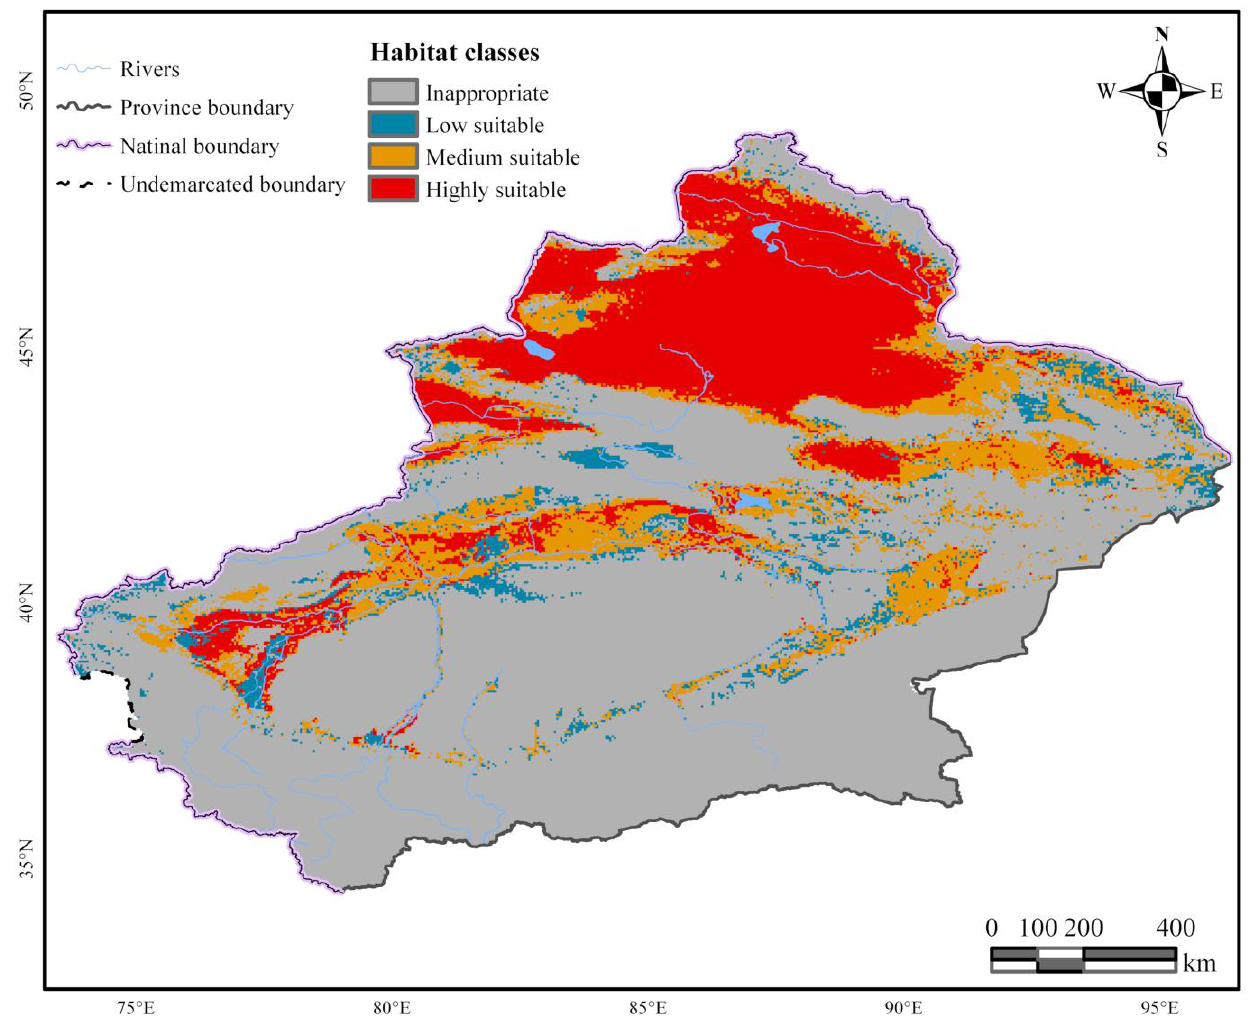
Figure 3. The habitat of HO (host factors only in C. deserticola distribution) in Xinjiang. And the highly suitable habitat is mainly in the northern region, and the medium and low suitable habitats are mainly in the southern region and around the Taklimakan desert.